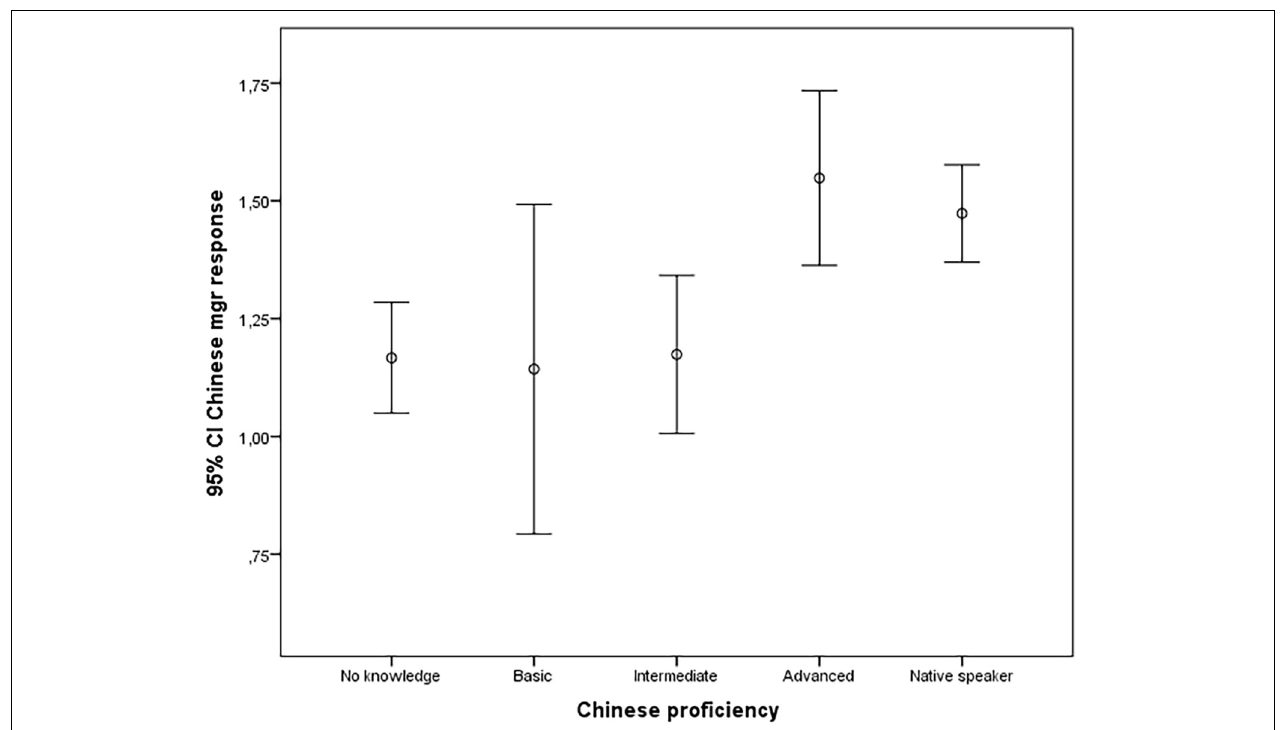
FIGURE 1 | The relationship between proficiency in Chinese language and the tendency to guess the most likely outcome of the scenario.